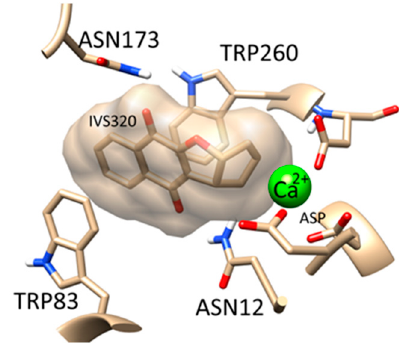
Figure 6. Possible binding mode of IVS320 in the Trypanosomatidae nucleoside hydrolase target.